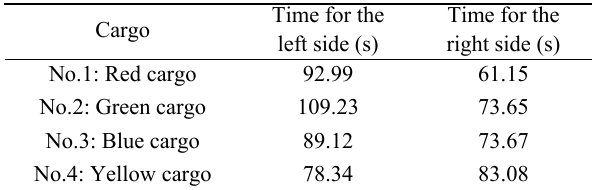
Fig. 6 Simulation comparison results of using two different facilities. Table 2 Time comparison of using two different facilities for the sorting